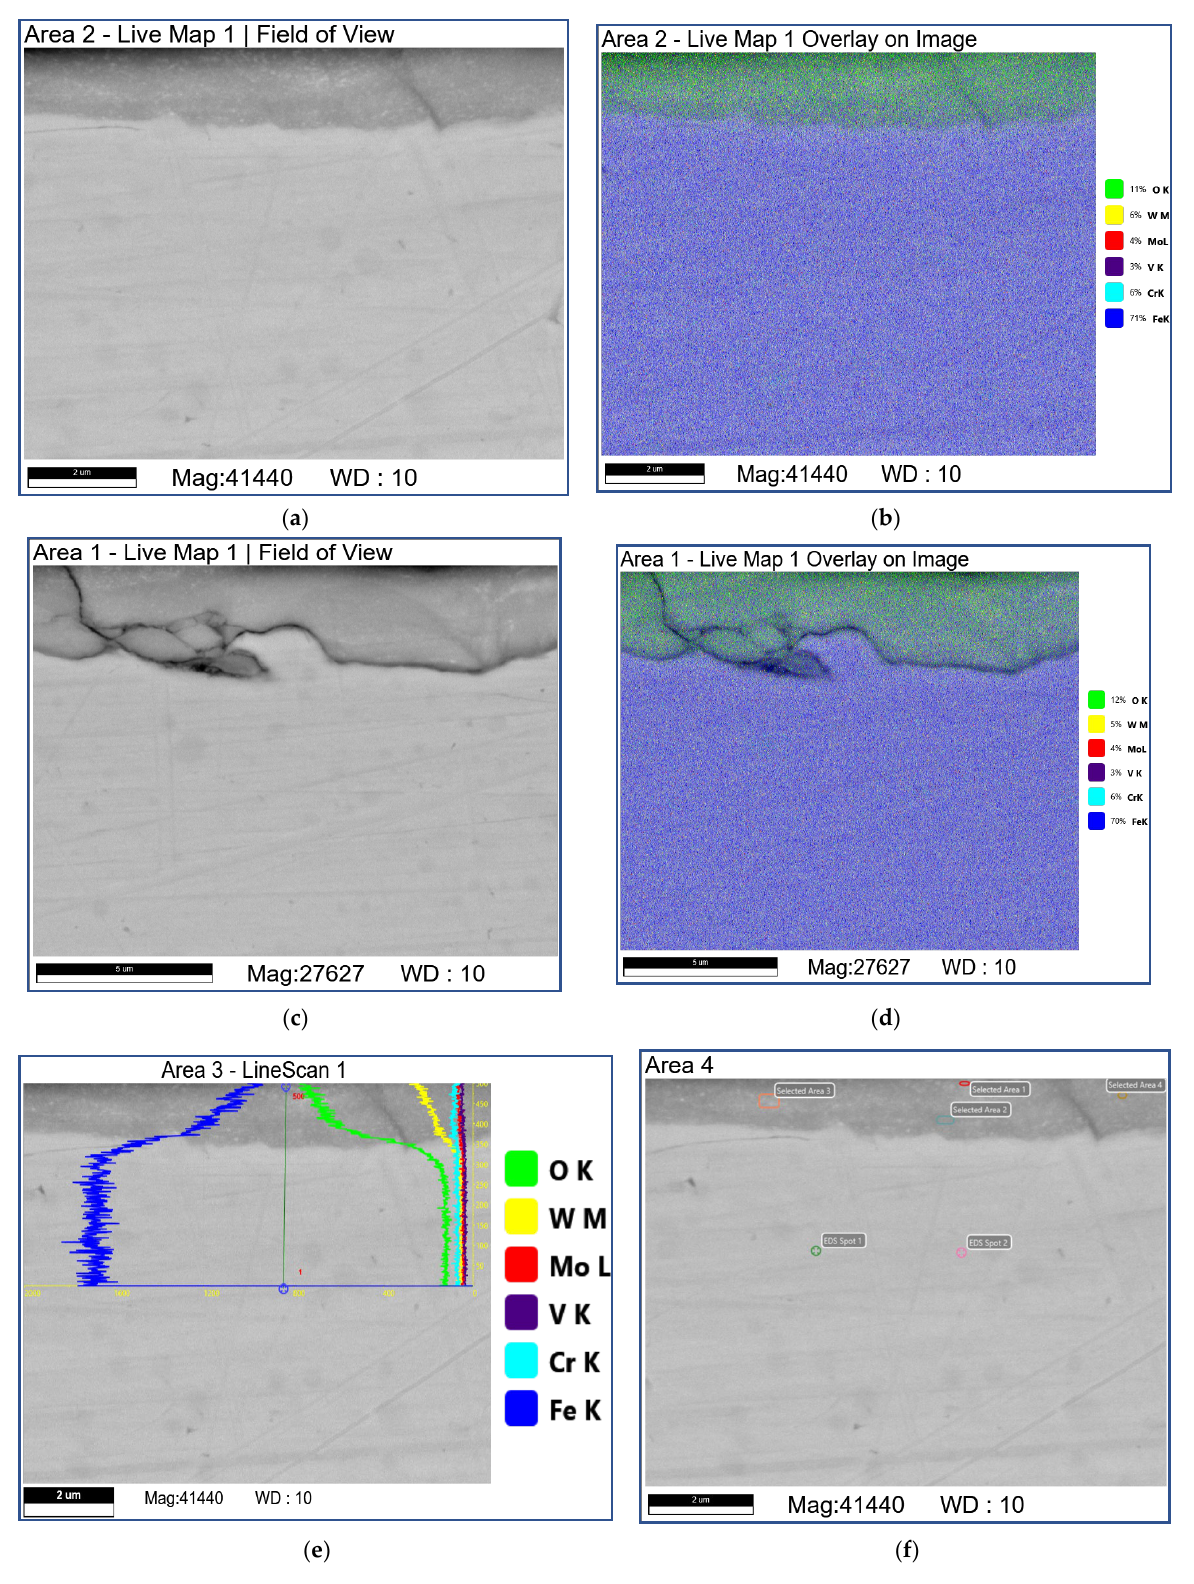
Figure 17. The SEM BSE images ( a , c , e , f ), overlay EDS image ( b , d ) and EDS line scans ( e ) of AISI 52,100 subsurface structures formed by sliding. Data presented for specimens after sliding speed of 3.6 m/s. Numbers on ( f ) indicate probe zones for which EDS elemental concentrations were determined indicated in Table 8. EDS elemental composition of subsurface area on AISI 52,100 counterbody after sliding at 3.6 m/s (Figure 17f) . Element, wt.% (at.%) Area